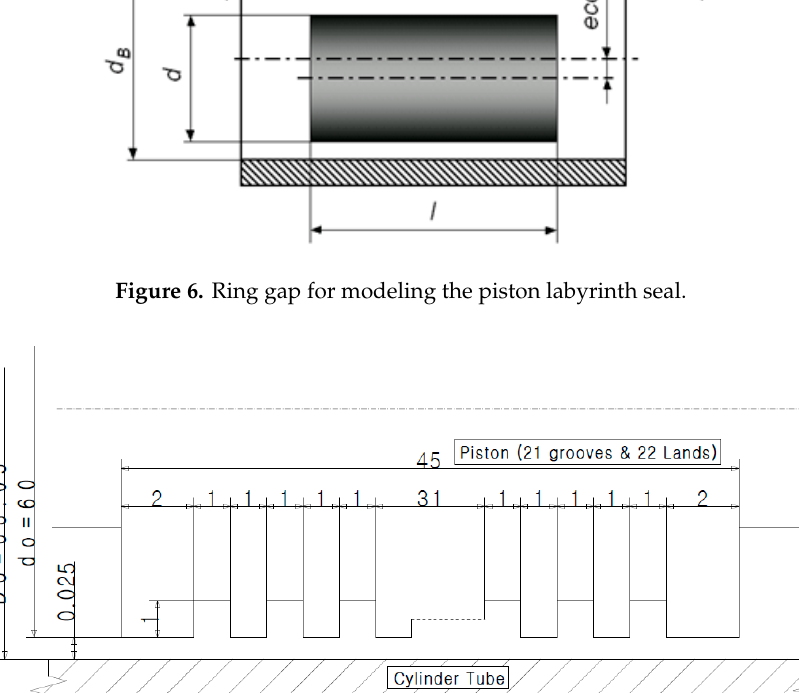
Figure 7. Dimensional arrangement of the five square grooves.